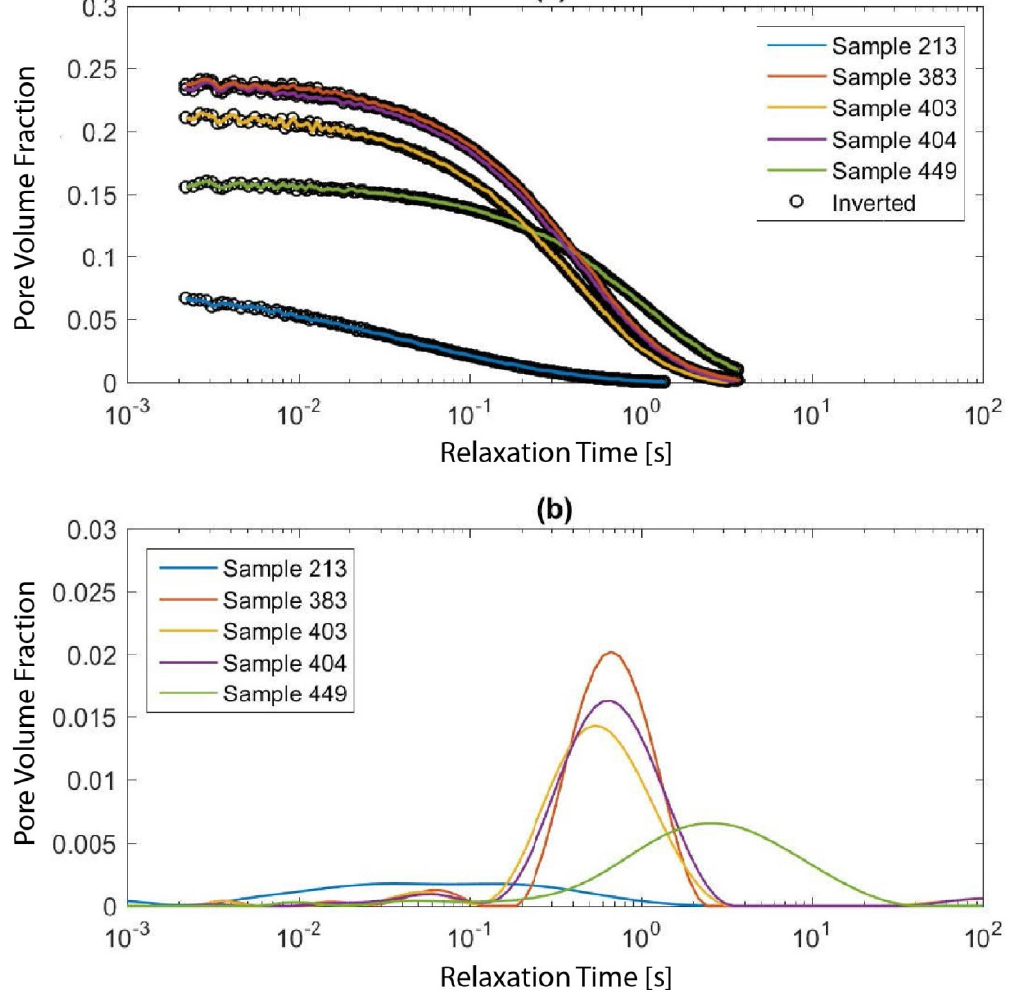
Figure 13. Inverted T 2 relaxation time distribution. In ( a ) the raw and the inverted data are compared. In ( b ) the inverted relaxation time distributions are presented. The presented curves are normalized in such a way, that the area below the individual curves is proportional to the measured porosity.